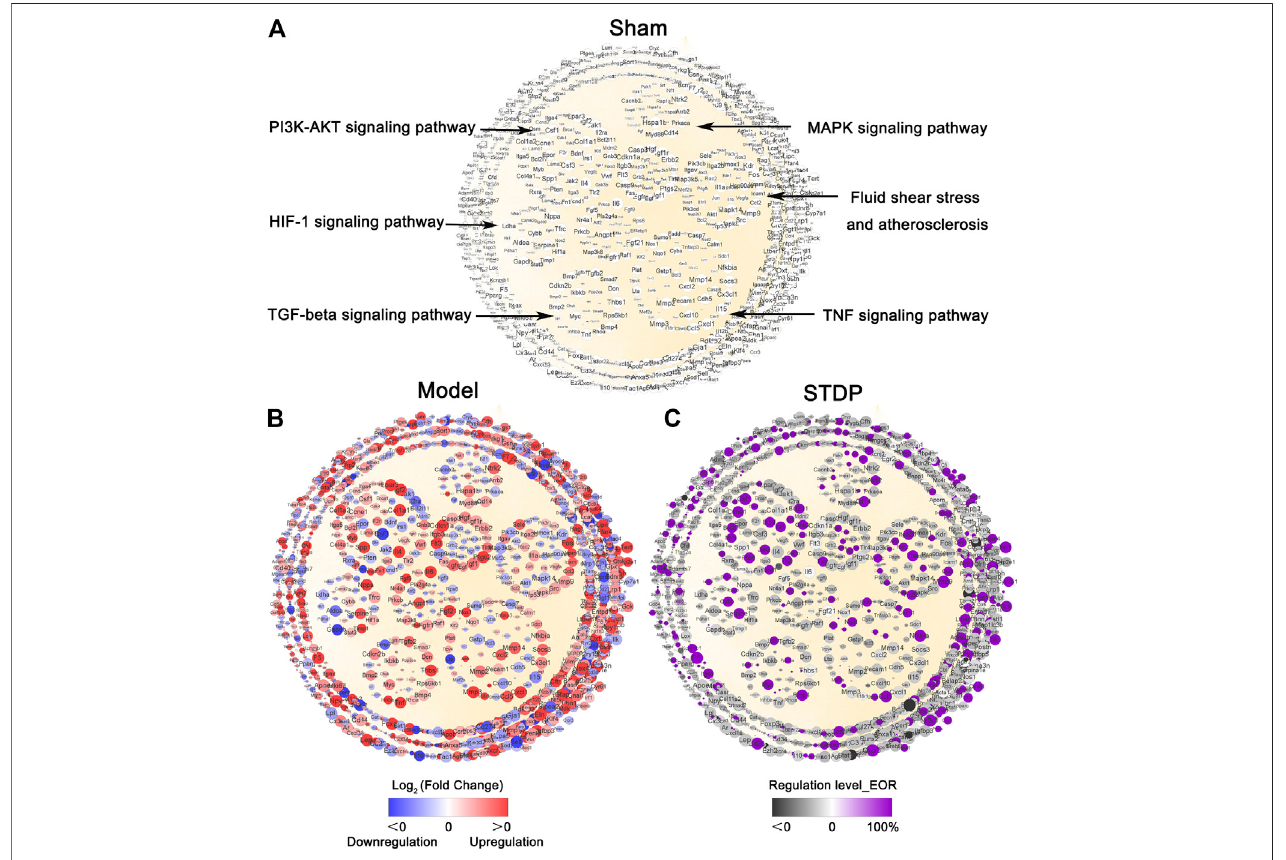
FIGURE4| STDPrecoversimbalancedCHFnetworkdisturbedbyTACmodeling. (A) CHFdiseasenetworkintheShamgroup.Eachnoderepresentsagene,and each edgerepresentstherelationshipbetween twogenesbasedon theprotein-proteininteraction.ThesizeofnoderepresentsNTRA rank, and thecircles inthe center of the network indicate the crucial pathways. (B) TAC modeling disrupted CHF network. The red color of the genes represents log2 Fold Change (Model/Sham) > 0, implying upregulated expression after TAC modeling; whereas blue indicate log2 Fold Change (Model/Sham) < 0, meaning downregulated gene expression by TAC.Thegradationofthecolorindicatesthedegreeofgeneupregulationanddownregulation. (C) TherecoveryregulationofSTDPonCHFnetwork.Thepurplecolorof the gene indicates that the recovery ef fi ciency EoR > 0. It means that STDP treatment shows a recovery effect on the gene. The black color indicates no effect.